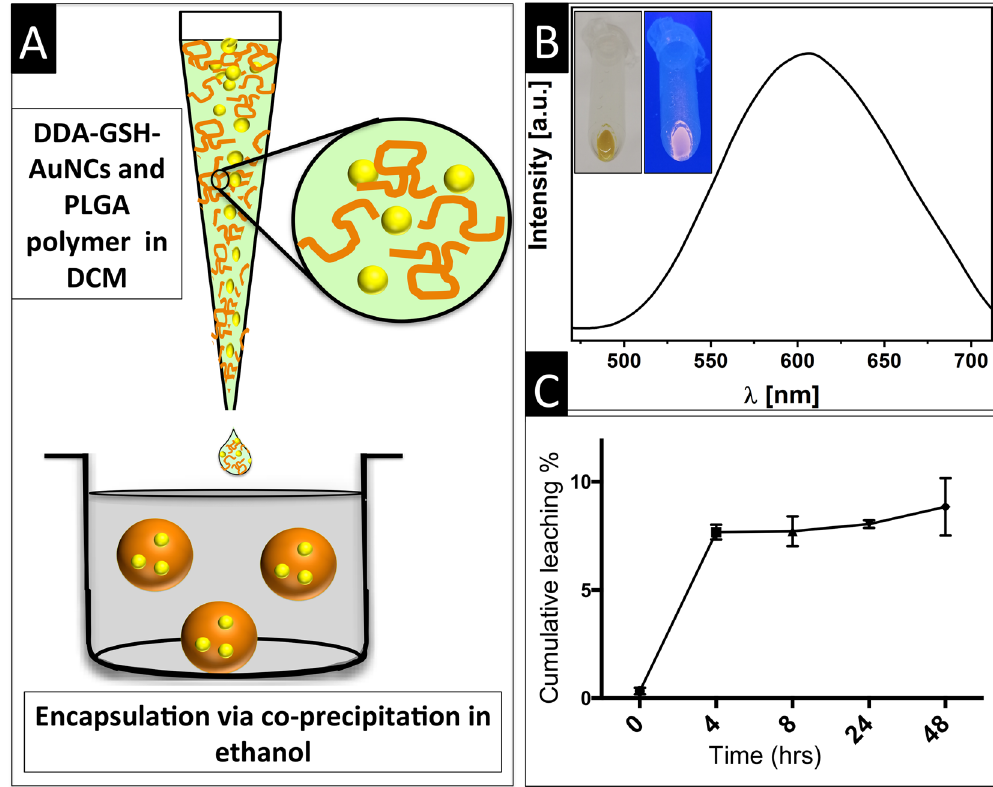
Figure 4. ( A ) Sketch shows encapsulation of DDA-GSH-AuNCs into PLGA nanoparticles using the nanoprecipitation method. ( B ) Florescence spectra of PLGA nanoparticles encapsulating DDA-GSH-AuNCs (Insert: digital photograph of pellets of PLGA nanoparticles encapsulating DDA-GSH-AuNCs under daylight (left) or long-wavelength UV lamp irradiation (365 nm) (right)). ( C ) Leaching of encapsulated DDA-GSH- AuNCs from PLGA nanocarriers as function of time. Total leaching was calculated as percent to initial load of DDA-GSH-AuNCs in to PLGA nanoparticles. Values represent average and standard deviation of three independent